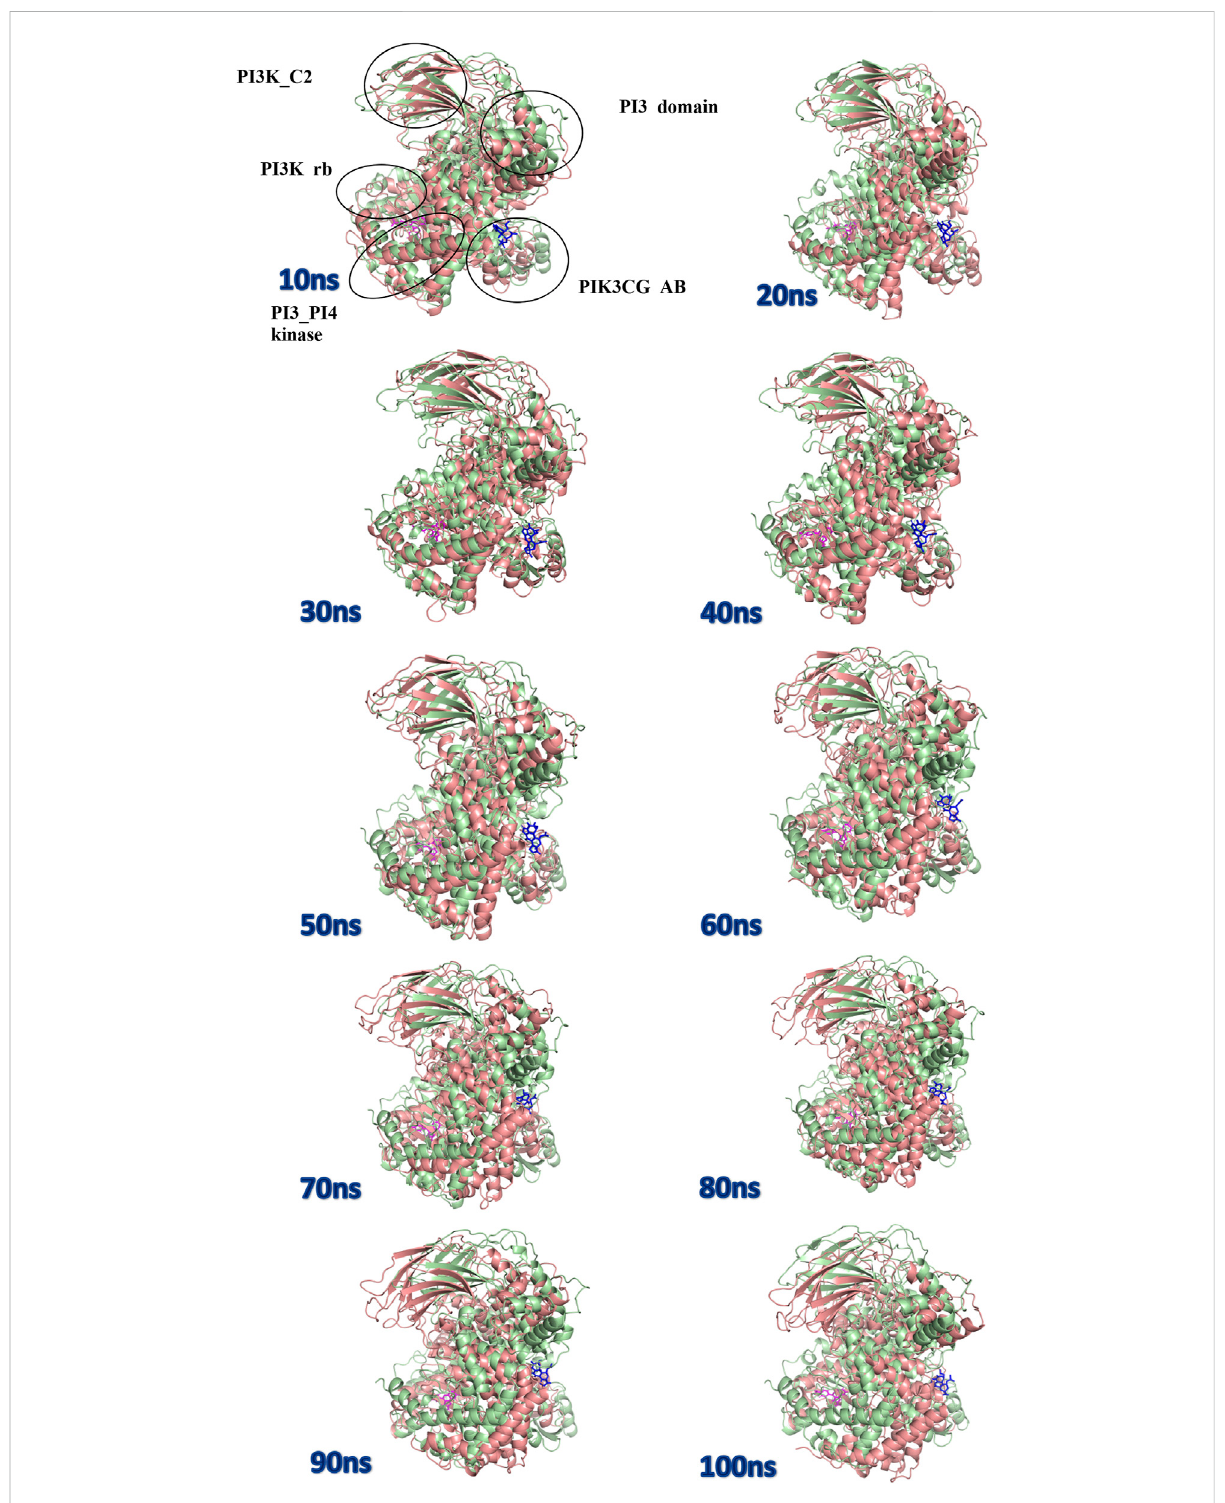
FIGURE 11 Superposition of complex structures of Wortmannin – 1E7U and 1j – 1E7U after simulation for 10, 20, 30, 40, 50, 60, 70, 80, 90, and 100 ns.